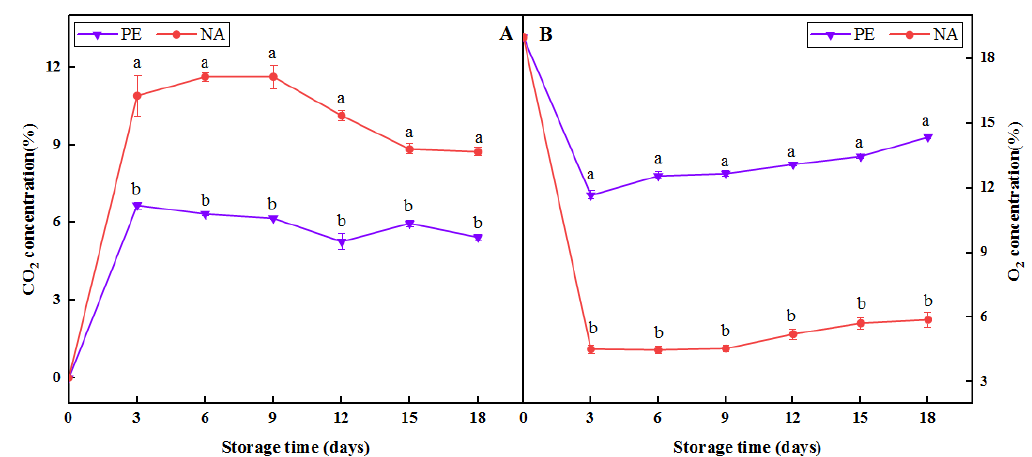
Figure 1. Effects of different types of packaging on CO 2 ( A ) and O 2 ( B ) levels in postharvest F. velutipes packaging microenvironments.